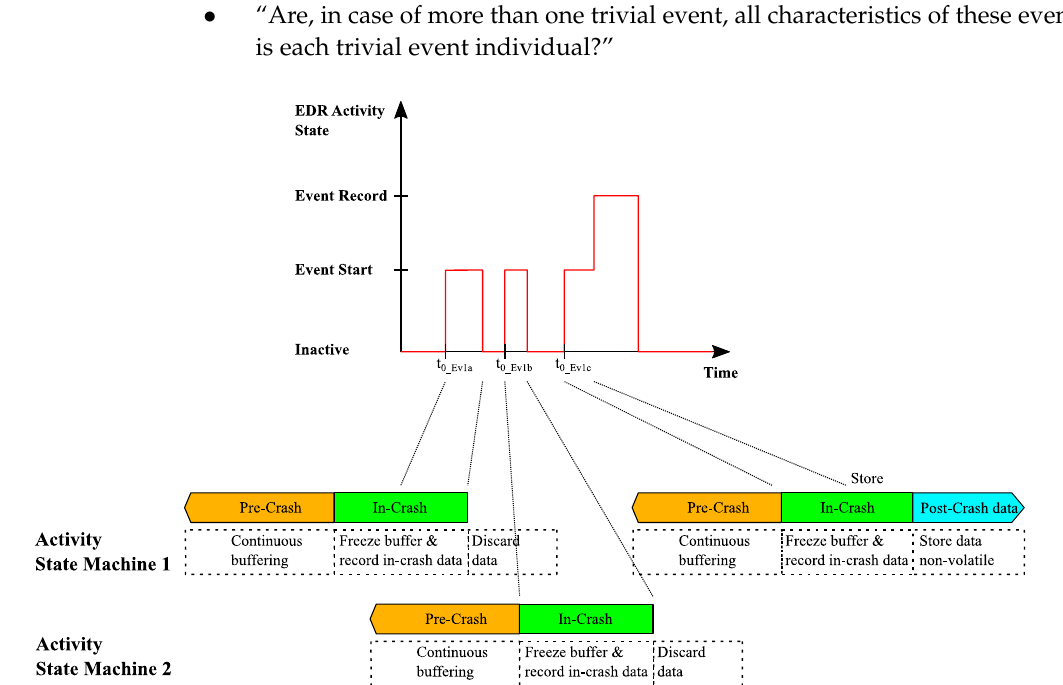
Figure 8. State machine activity depending on the EDR activity state.